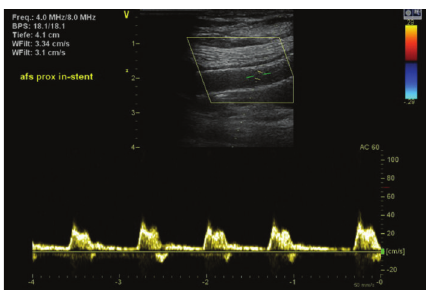
(Figure 3(b)). Subsequently, good angiographic flow was shown in the SFA and in the popliteal artery with a 1- vessel run-off of the anterior tibial artery (Figures 3(c)–3(f)). limb paleness and paresthesia were completely resolved.